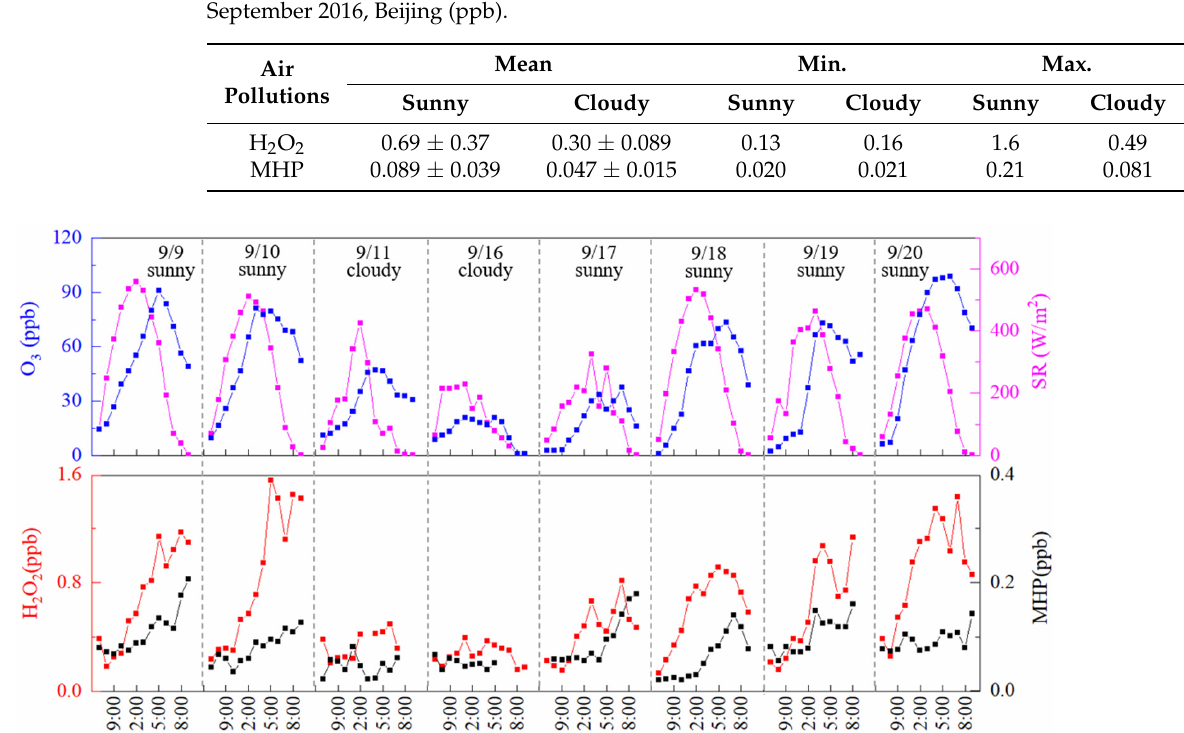
Figure 9. The diurnal variation of the concentrations of O 3 , H 2 O 2 , and MHP in September 2016, Beijing.